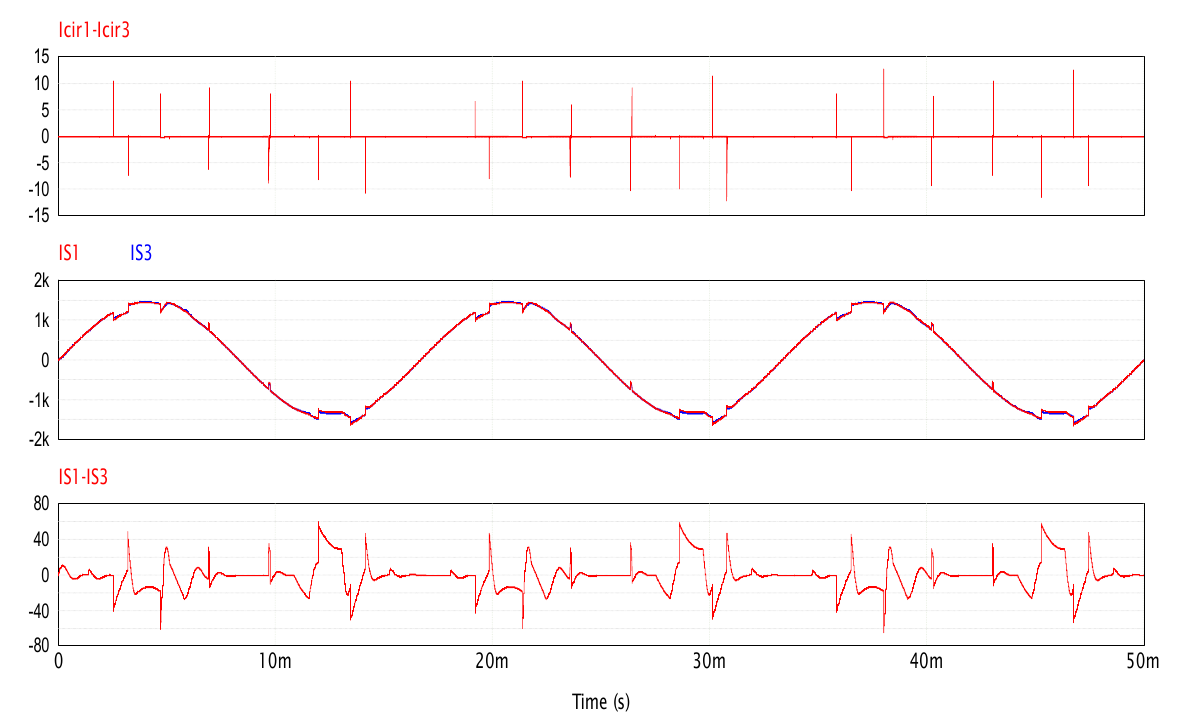
Figure 16. Evaluation of the network equalizer tolerance to variation.